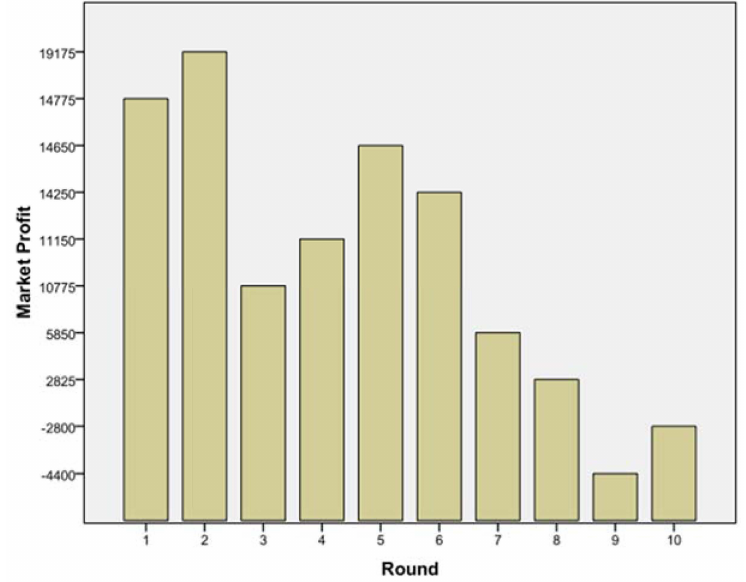
Figure 6. Total market profit over a period of 10